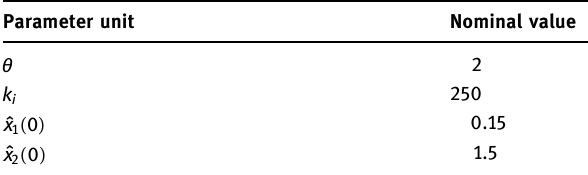
Table 3: Gains and values of ( 19 ) and ( 17 ) Parameter